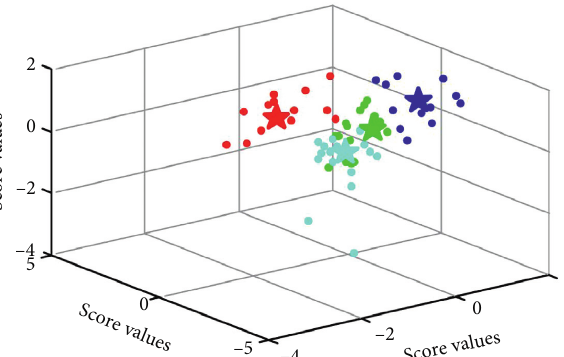
Figure 10: The clustering